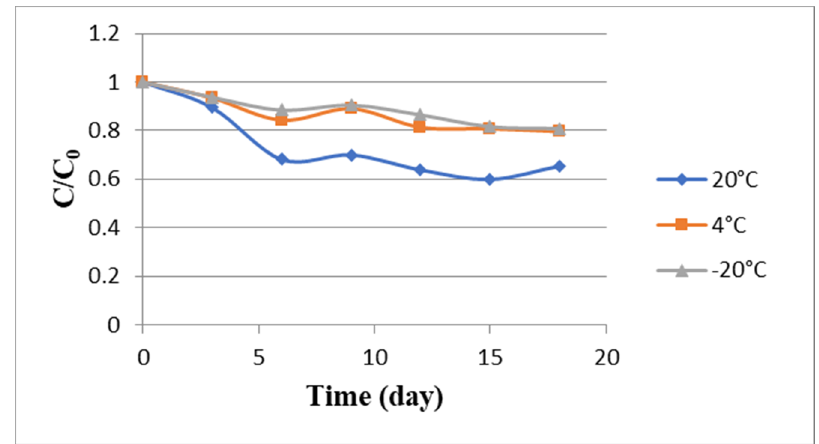
Figure 5. Degradation kinetics of Roselle anthocyanin in SAFA m during storage at different temperatures.